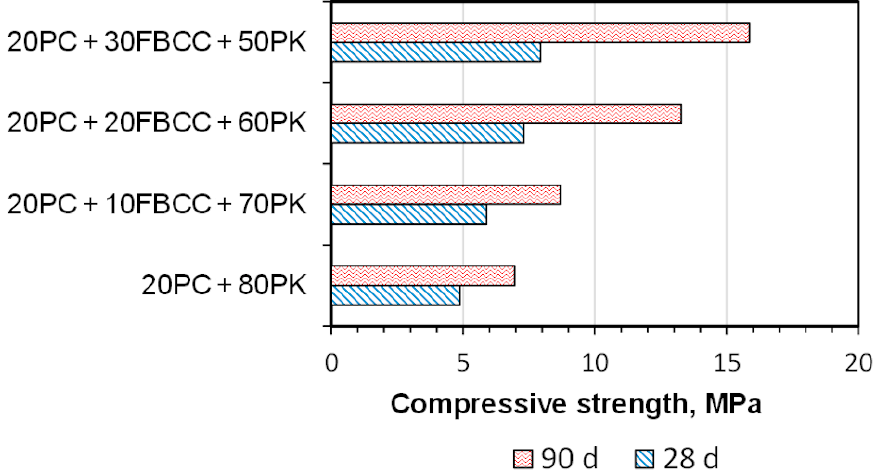
Figure 14. Compressive strength of blended binder mortars after 28 and 90 days of hydration.